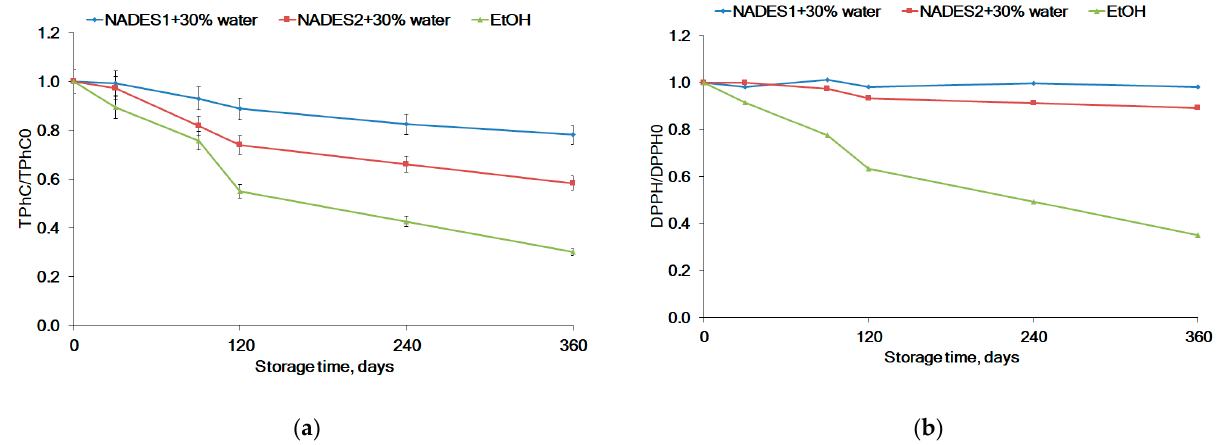
Figure 6. ( a ) The dynamic of the total phlorotannins content (TPhC) and ( b ) DPPH scavenging activity during the storage of F. vesiculosus extracts at 25 °C in a dark place for 360 days.